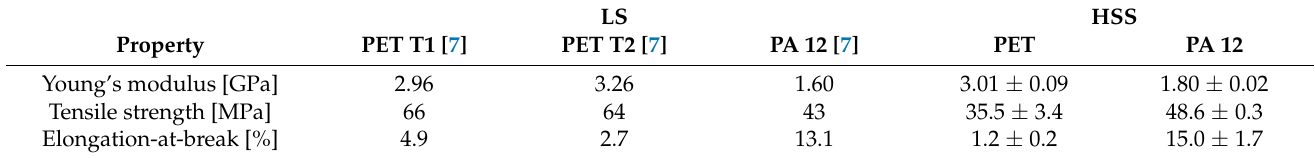
Figure 11. Stress-strain-curves of PET tensile bars manufactured under conditions of the very low bed temperature possible with the HSS machine ( a ) and HSS manufactured PA 12 specimens under optimized conditions ( b ). Table 2. Comparison of mechanical properties of tensile specimens manufactured from PET by LS (Adapted from [7]) and HSS with the same powders. T1 was PET manufactured by LS in a laboratory LS machine with scanning speed of 5 m/s. T2 was PET manufactured by LS in a commercial LS machine with scanning speed of 12 m/s. For HSS, voxeljet Ink Type B at the speed was 0.09